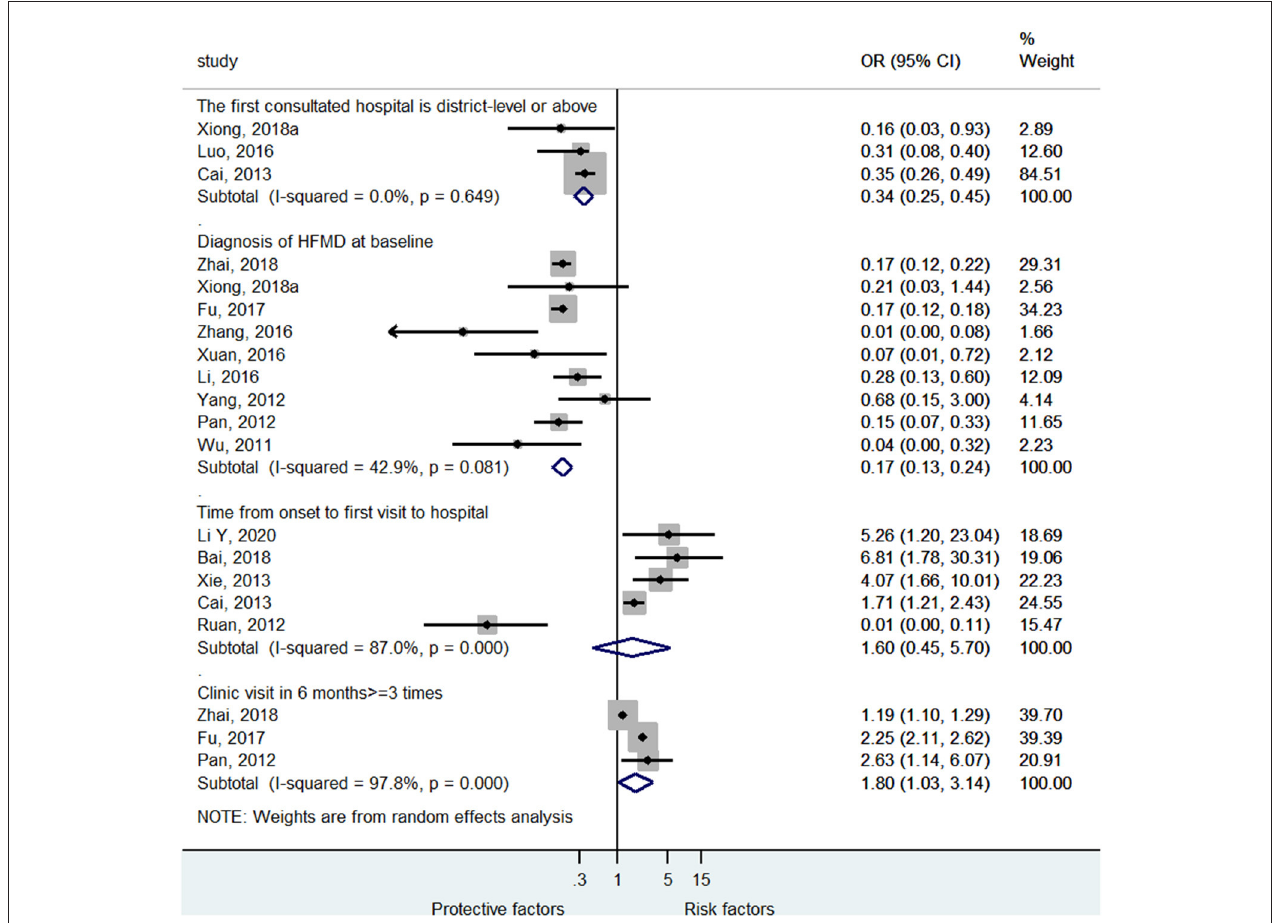
FIGURE 5 | Forest plot for the association of the clinical pathway characteristics with severe hand foot mouth disease.